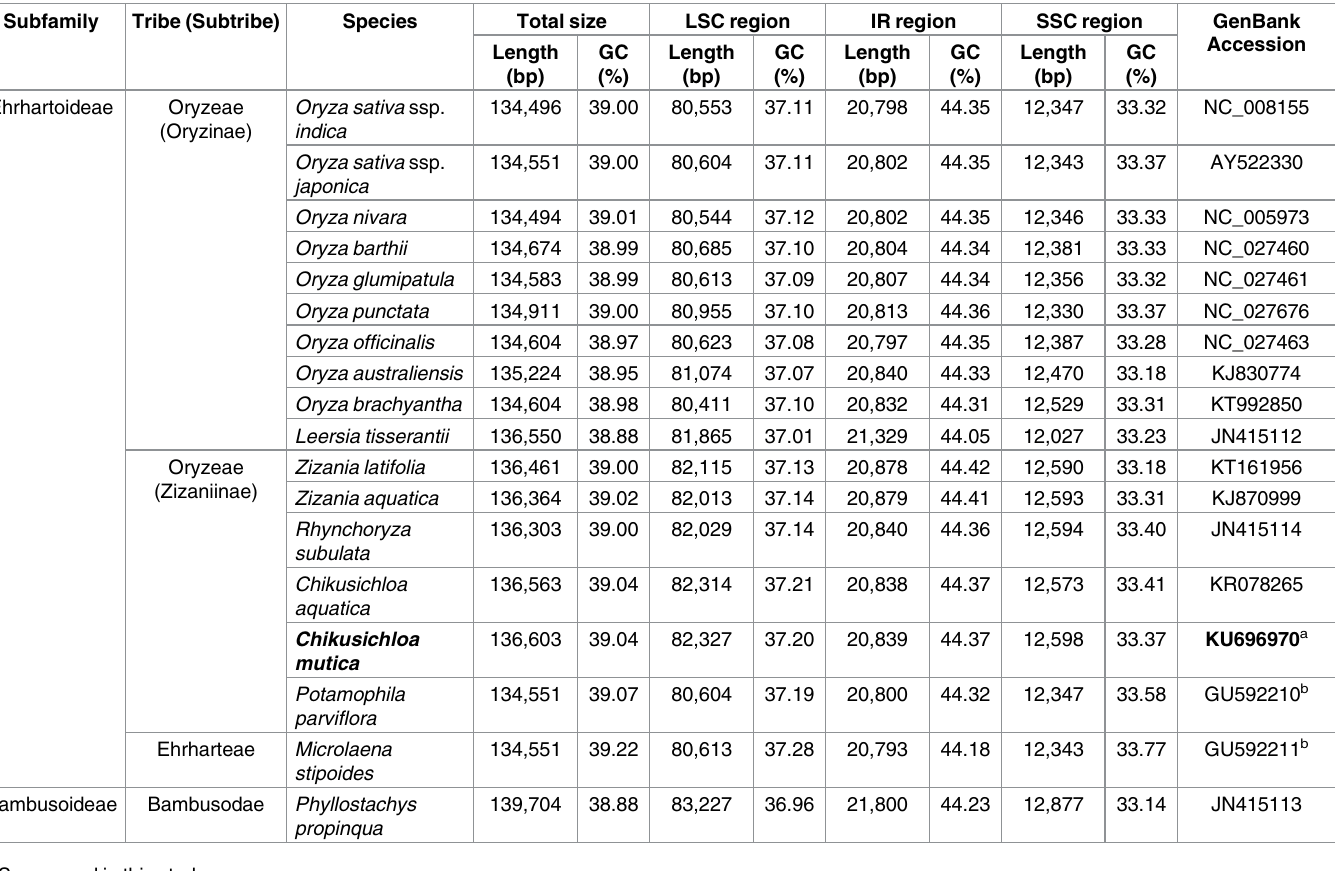
Table 2. Comparison of major featuresof 18 Poaceae chloroplast genomes from Ehrhartoideae and Bambusoideae subfamilies. Subfamily Tribe